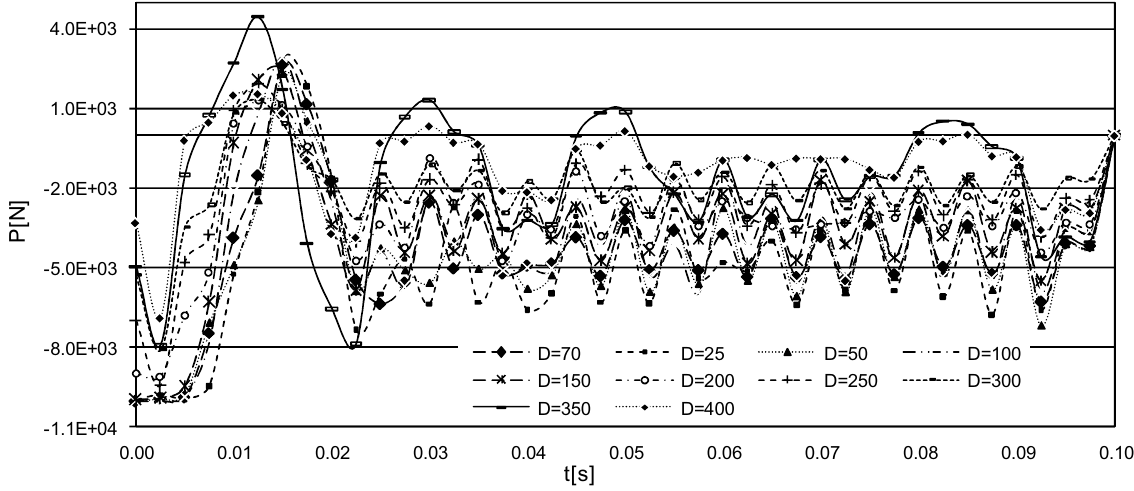
Fig. 5. Optimum control force without preview control with the reduced feasible region strategy.